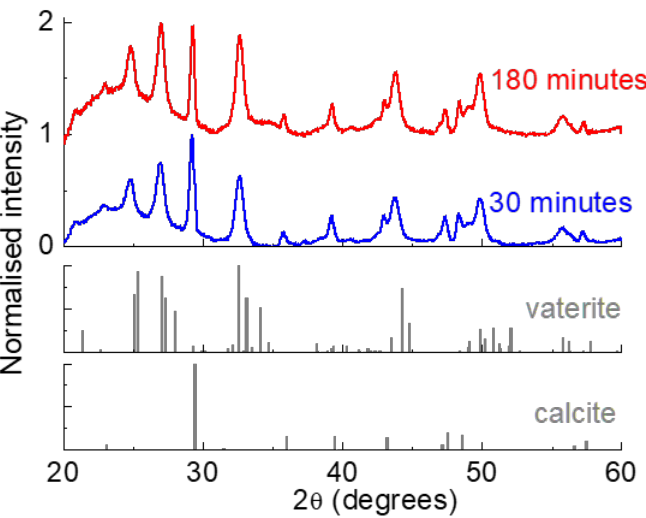
Figure 4. XRD patterns for samples prepared in W:EG 1:5 for 30 and 180 min. The acquired data are compared to the standard patterns for calcite and vaterite.